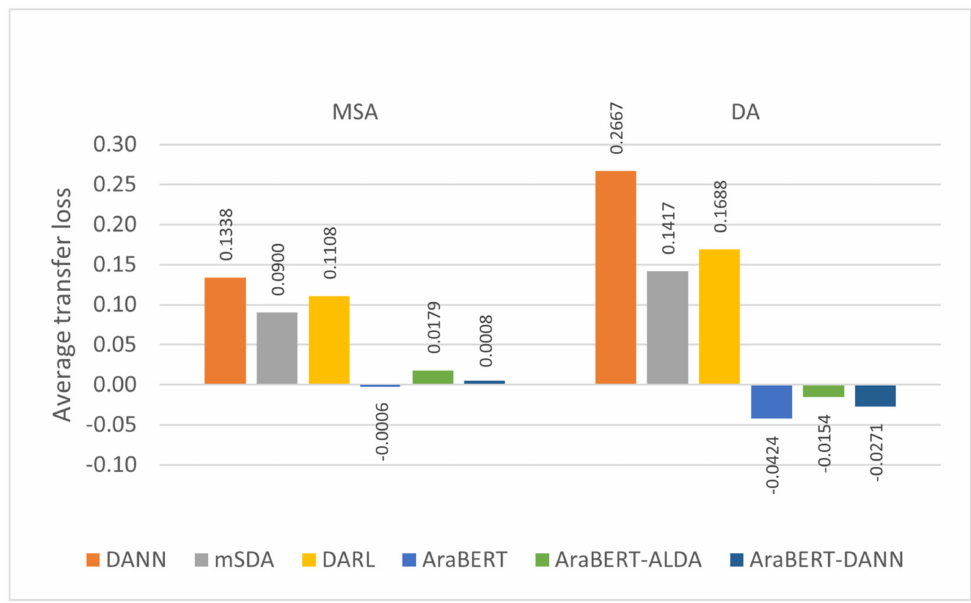
Figure 3. Average transfer loss of each method on MSA and DA